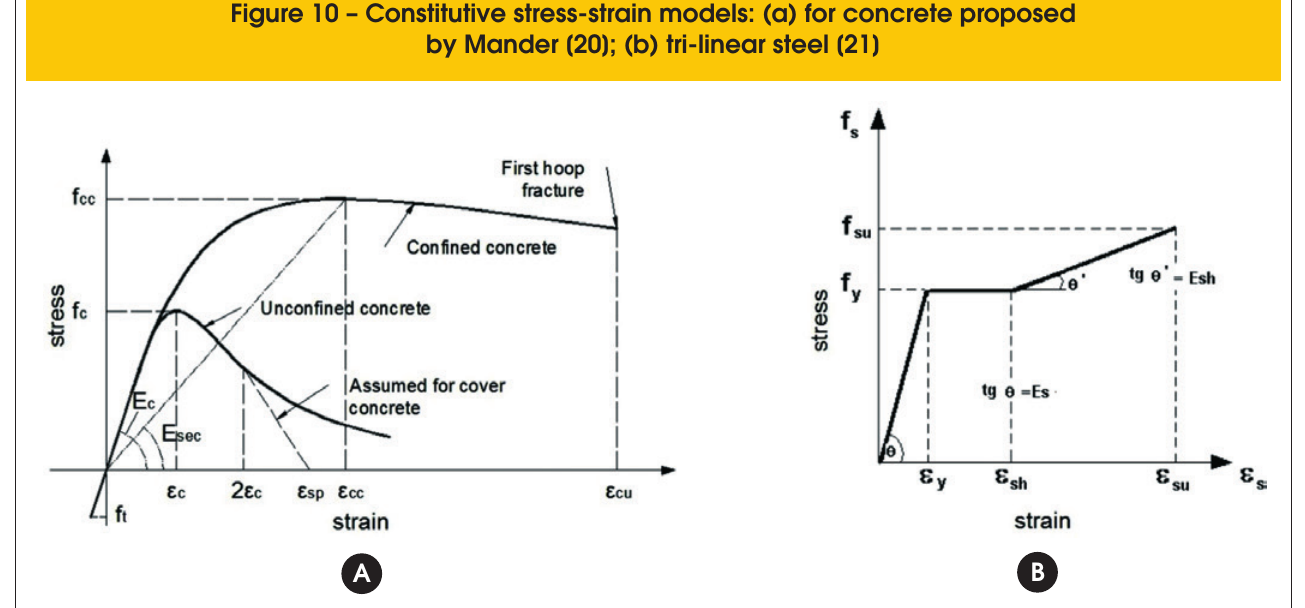
Figure 10 – Constitutive stress-strain models: (a) for concrete proposed by Mander [20]; (b) tri-linear steel